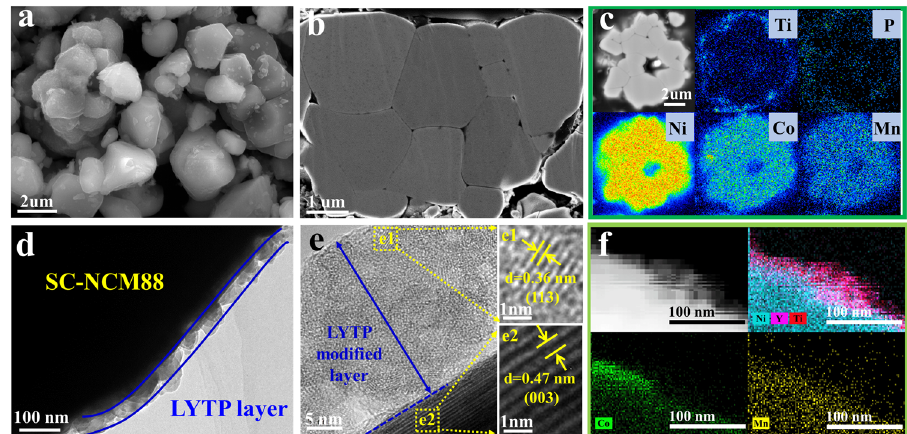
Fig. 2 Representative electron microscopy images of LYTP@SC-NCM88. a Overall and ( b ) cross-sectional morphologies derived from SEM images. c Cross-section EPMA image of 1% LYTP@SC-NCM88 with the corresponding selected area LYTP mapping results of Ni, Co, Mn, Ti, and P elements. d TEM, ( e ) HRTEM, and ( f ) STEM elemental mappings of Ni, Co, Mn, Y, and Ti for 1% LYTP@SC-NCM88.